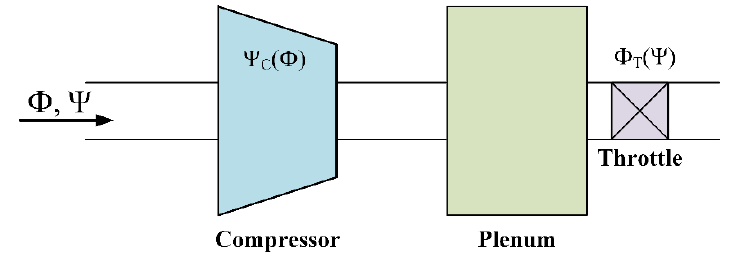
Figure 2. Schematic diagram of the compression system.